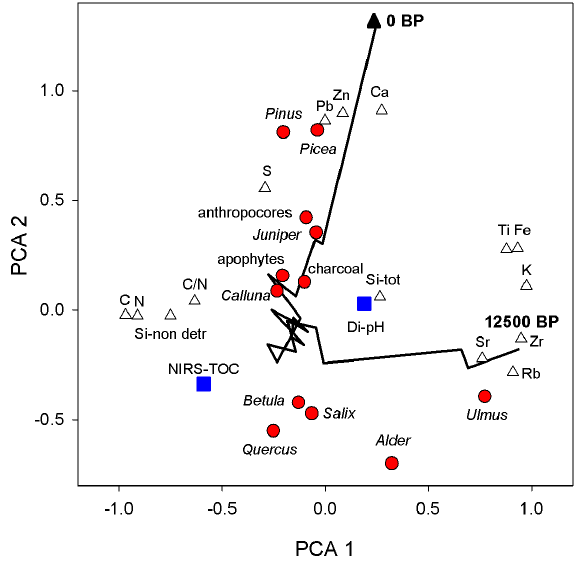
Fig. 6. Principal component analysis of all major pollen types, ele- ments and inferred water chemistry. The loading values (sediment depth) and score values (environmental variables) are plotted to- gether to assess correlations among all variables through